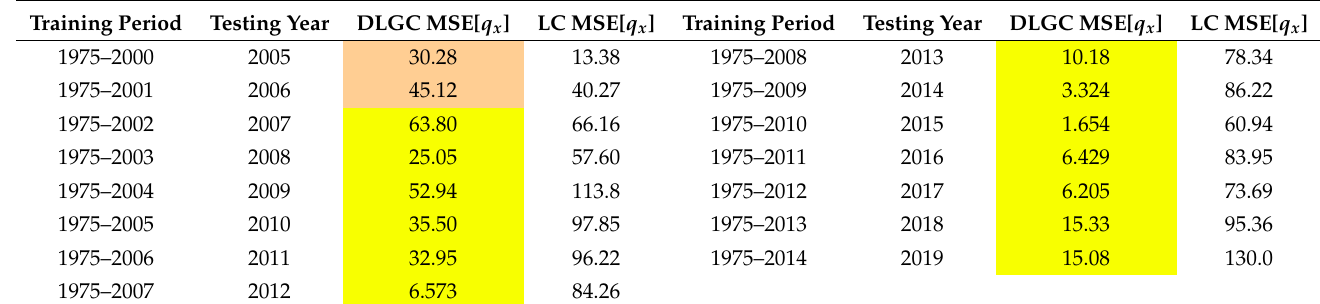
Table 5. Five-year-ahead rolling-window cross-validation using USA male